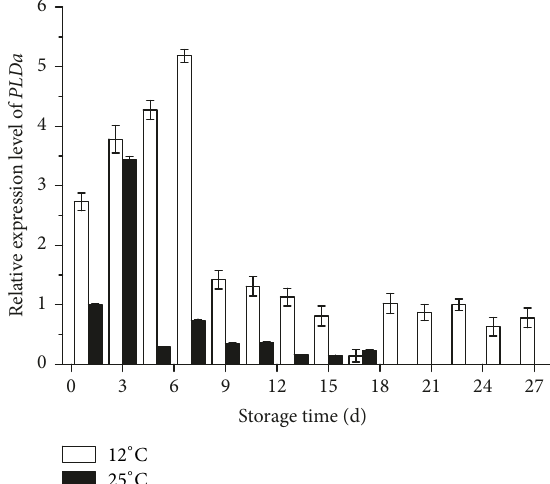
Figure 3: Expression of gene MaPLD 𝛼 in different banana organs. Equivalent cDNA amounts from different banana organs, that is, floral buds (Fb), flowers (Flo), green leaves (Gl), senescent leaves (Sl), pseudo stem (Ps), stem (St), developing fruits at the broken bud stage (Df1), 30 days after the broken bud stage (Df2), and 60 days after the broken bud stage (Df3), and mature fruits (Mf), were analyzed by semiquantitative PCR as described in Materials and Methods, using primers specific for MaPLD 𝛼 and a housekeeping gene, actin, as an internal control. Expression levels are presented relative to that of senescent leaves, with a standard deviation ( 𝑛 = 5 ).